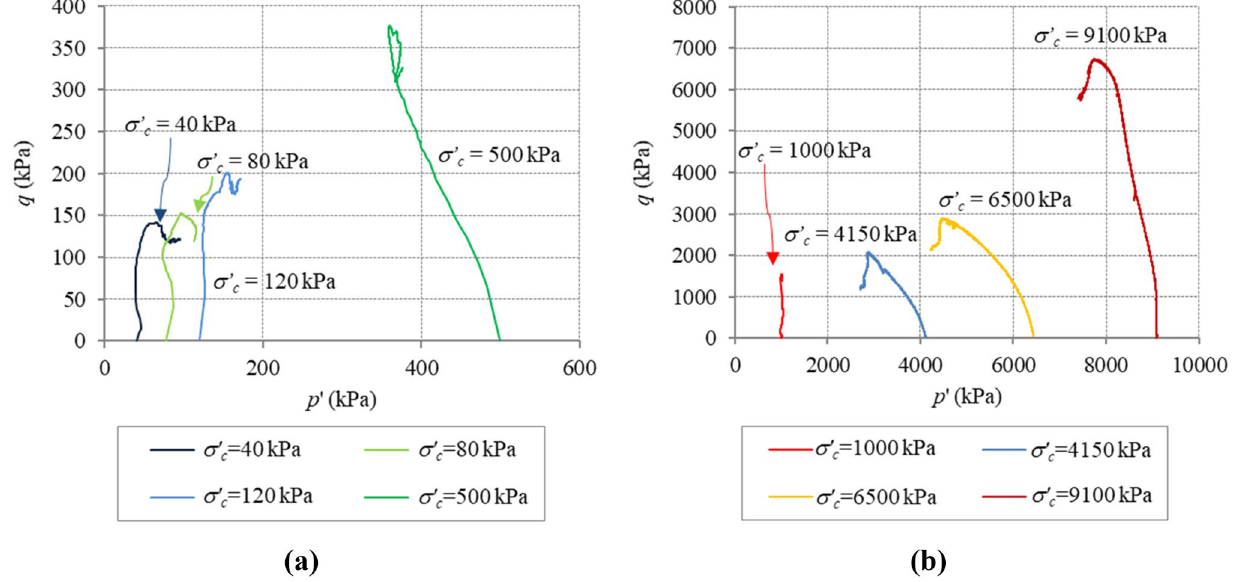
Fig. 9 Stress paths in undrained triaxial tests in the p ′ -q space: a overconsolidated samples; b normally consolidated